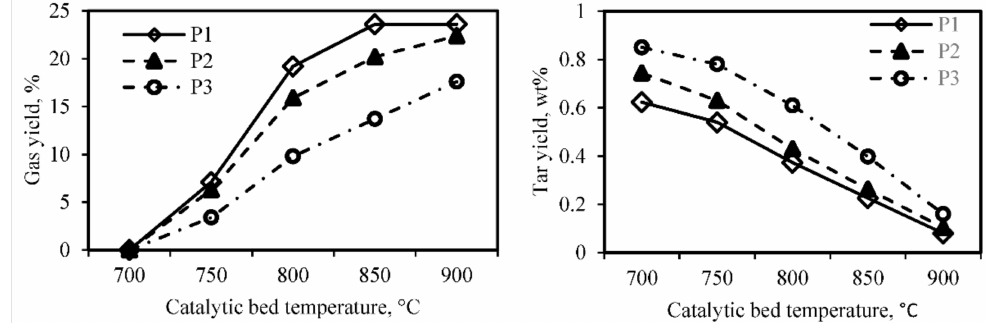
Figure 3. Effect of different catalyst to biomass (C/B) ratio on overall gas product composition.